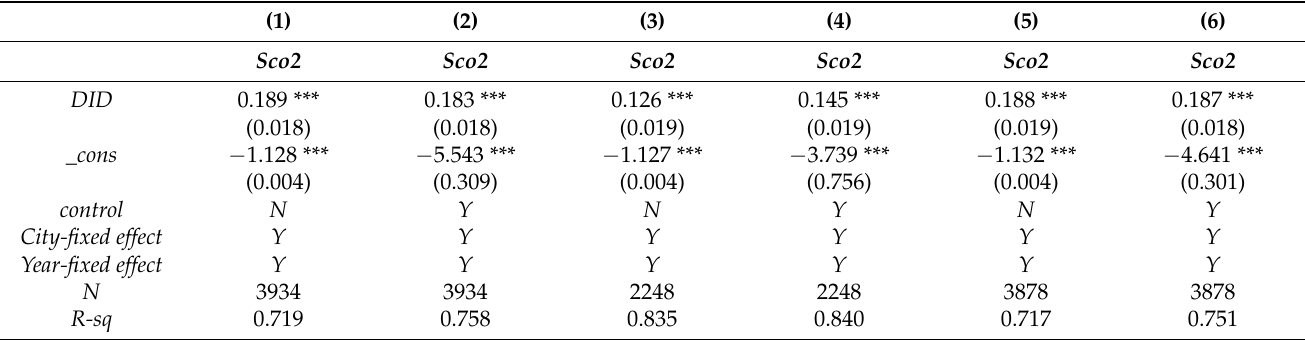
Table 7. Robustness